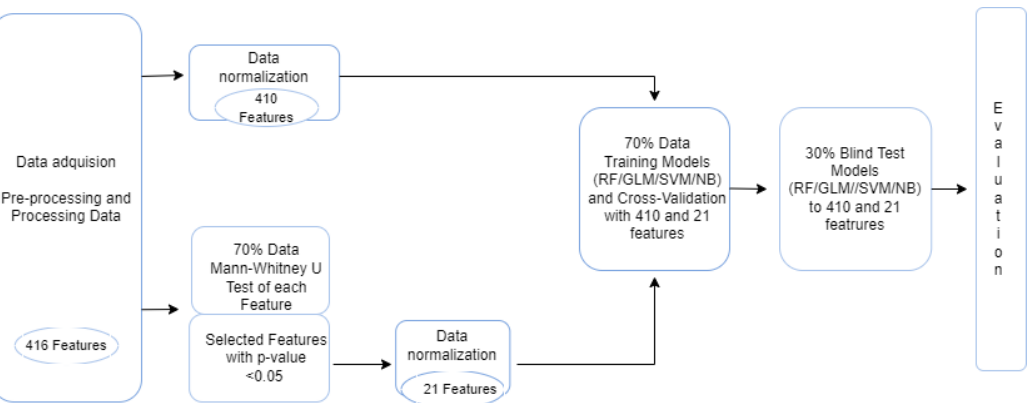
Figure 1. Flowchart of the steps that were followed for the development of the machine learning models, until their evaluation.